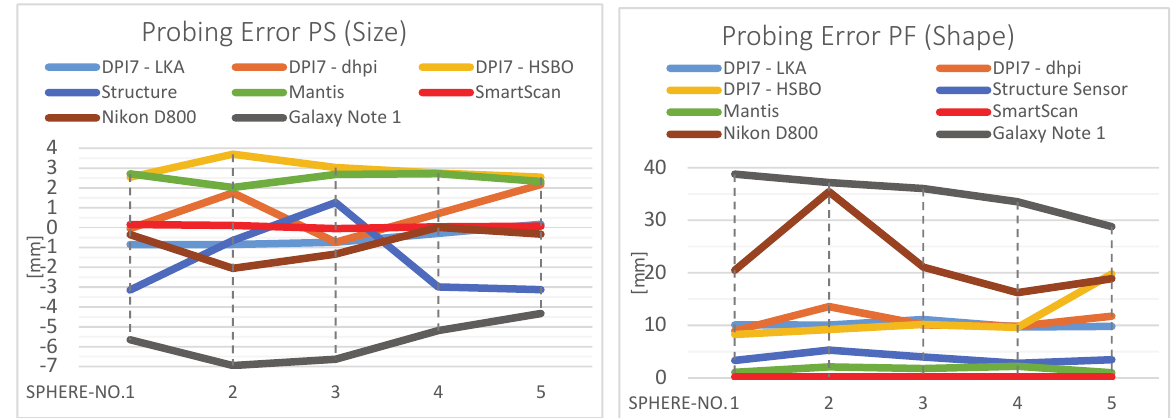
Figure 3. Quality parameter probing error (PS / PF) equivalent to VDI/VDE 2634, part